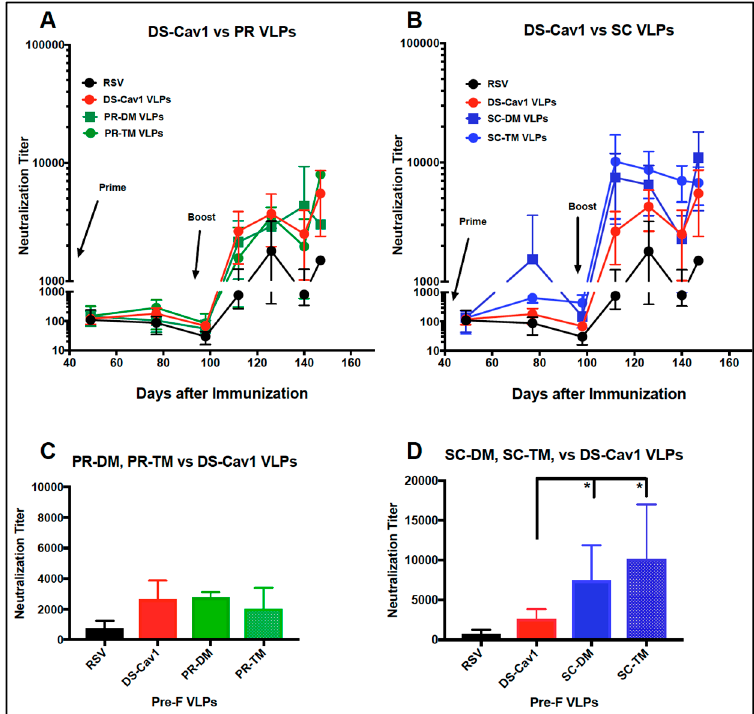
Figure 5. Neutralization titers in sera after VLP immunization. Sera obtained from each group of mice at each time point after the VLP prime immunization were pooled and NAbs titers determined in a classical plaque reduction assay. Panel A compares titers obtained with DS-Cav1 VLP sera with titers obtained with PR-DM VLP and PR-TM VLP sera. Panel B compares titers using sera from SC-DM and SC-TM VLPs with DS-Cav1 VLP sera. Panel C compares titers obtained at two weeks post-boost with the PR VLP sera, DS-Cav1 sera, and RSV infection with statistical analysis between groups. Panel D compares titers at two weeks post-boost with DS-Cav1 VLPs and SC VLPs and RSV infection with statistical analysis between groups. NAbs titers increase at day 150 due to boost effects of the RSV challenges of mice at day 147, four days before sacrifice. Results are the mean with standard deviation of three to six separate determinations. Comparison of titers obtained with DS-Cav1 and SC-VLP sera at two weeks post-boost was assessed by one-way ANOVA. There were no differences between DS-Cav1 and PR-VLP sera. * p < 0.05.